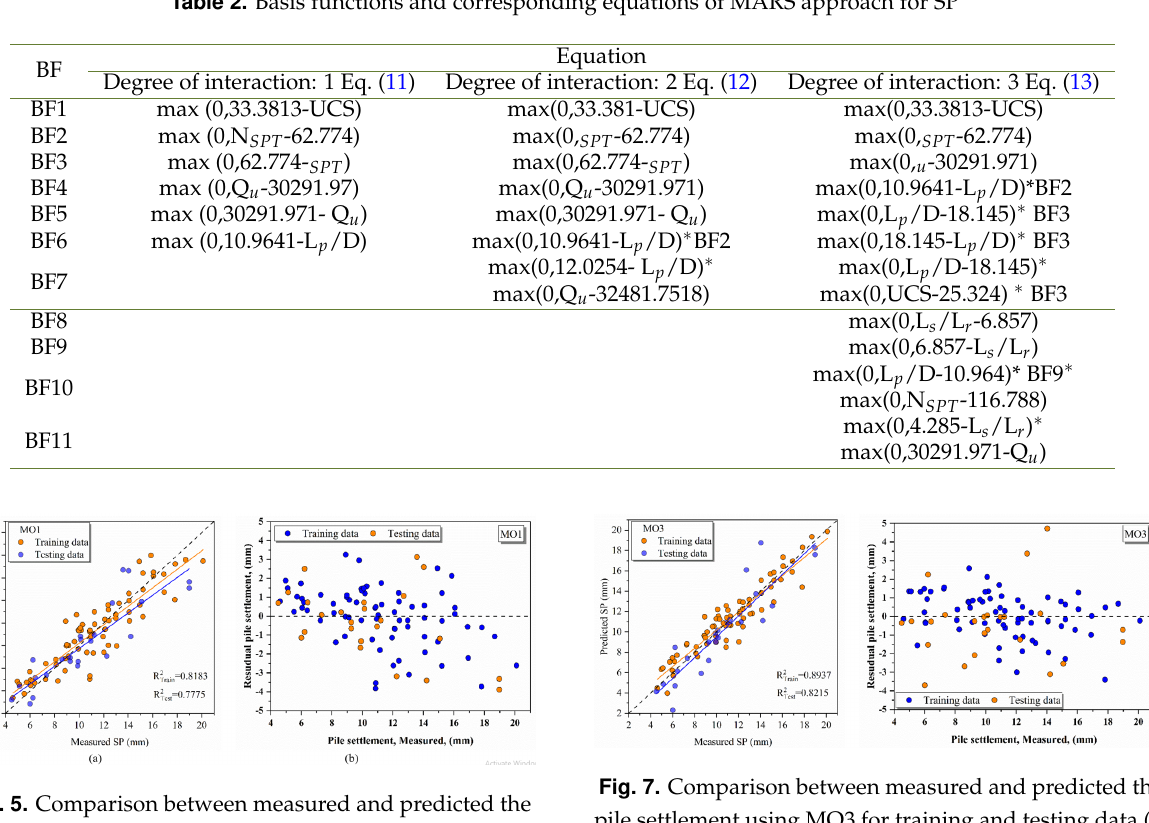
The more frequency of error values zero or close to zero are,